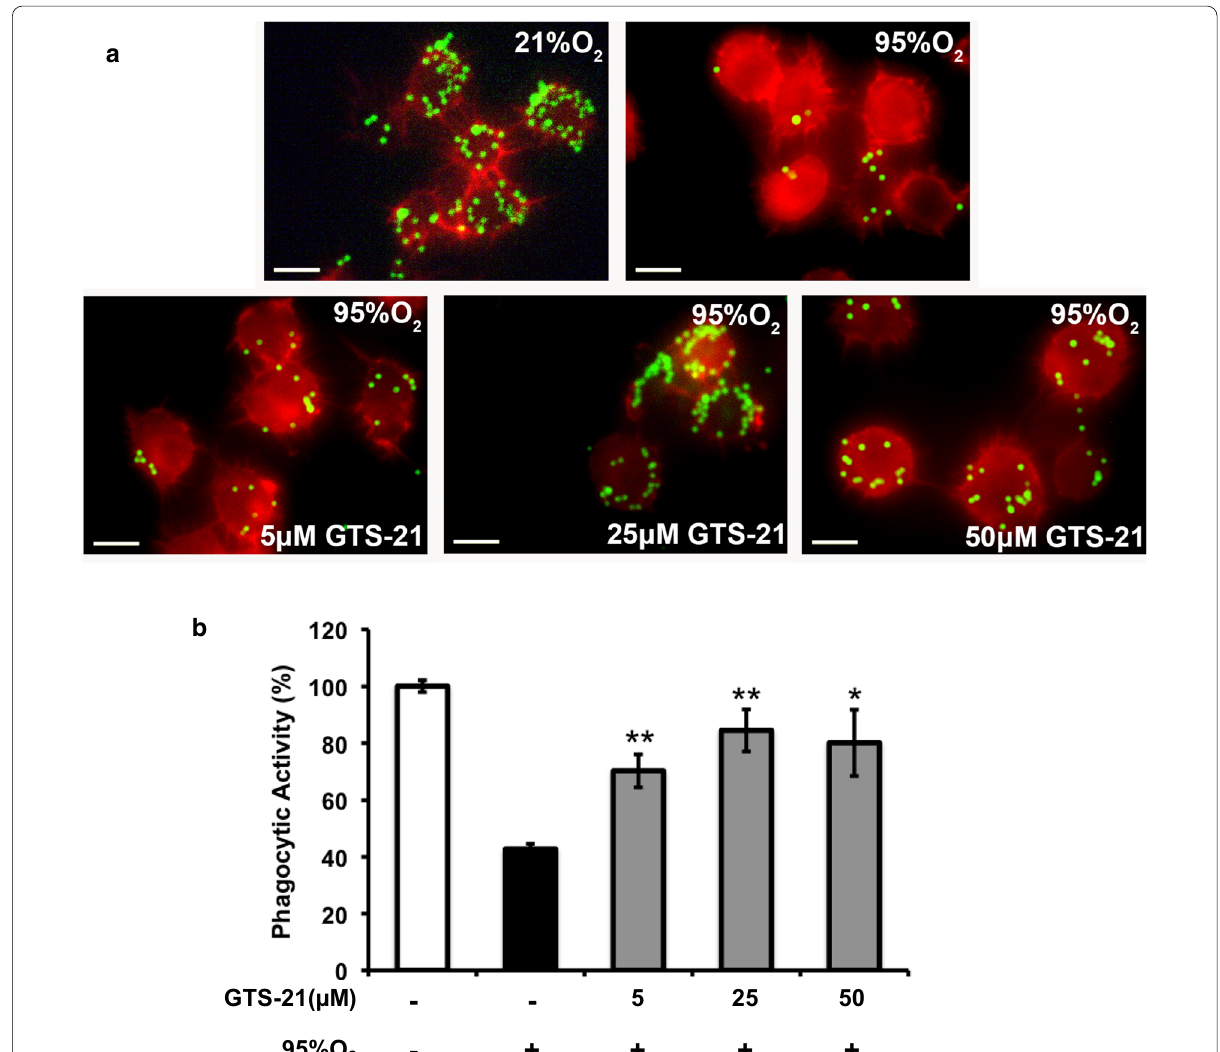
Fig. 2 GTS-21 restores hyperoxia-compromised phagocytic activity of macrophages. RAW 264.7 cells were either exposed to 95% O 2 alone (black bar) or 95% O 2 in the presence of different concentrations of GTS-21 (grey bars) or remained at 21% O 2 (white bar) for 24 h. Cells were then incubated with FITC-labeled latex minibeads for 1 h and stained with phalloidin to visualize the cells. a Immunofluorescent images of RAW 264.7 cells (Red: actin cytoskeleton; Green: minibeads). At least 250 cells per well from 3 independent experiments were counted and the number of beads per cell was represented as percent beads phagocytosed in the bar graph ( b ). Each value represents mean experiments for each group. *p < 0.05 and **p < 0.01 versus 95% O 2 alone (black bar). Bar, 10